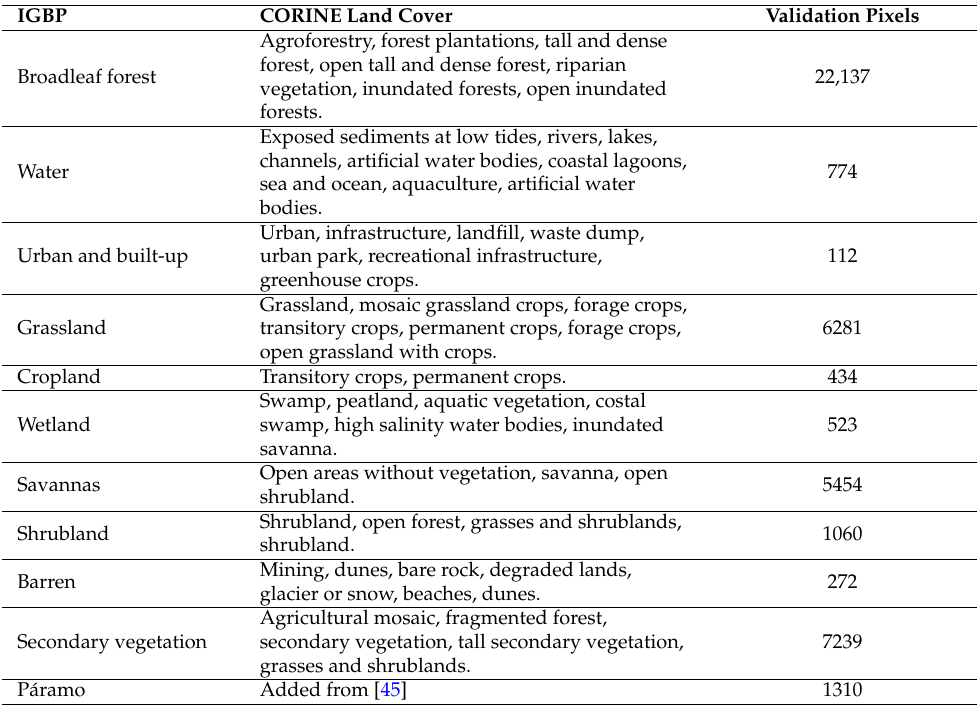
Table 3. Aggregation of CLC [2] classes into IGBP classes, 1% of the pixels were randomly selected from each class for accuracy